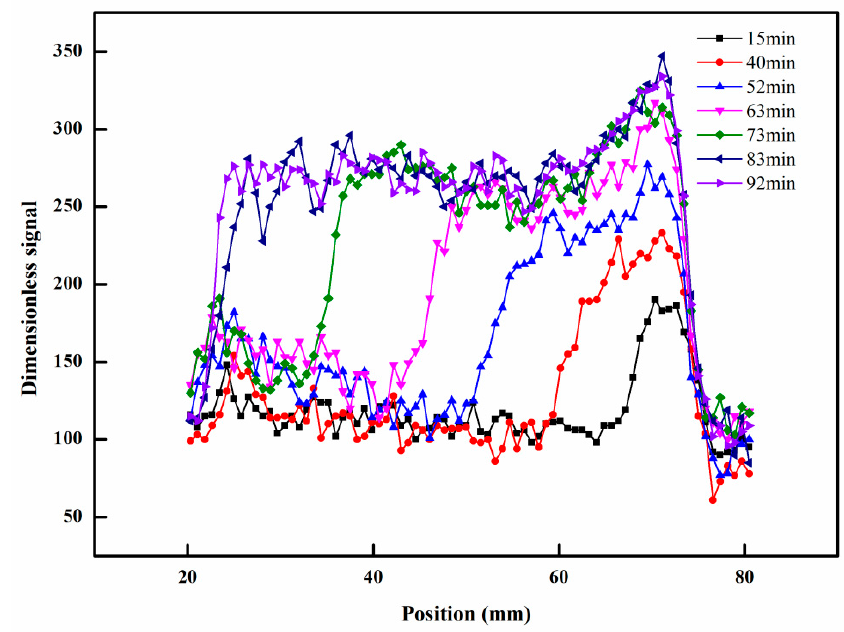
Figure 6. One-dimensional frequency coding of the fracturing fluid imbibition process of core 96.